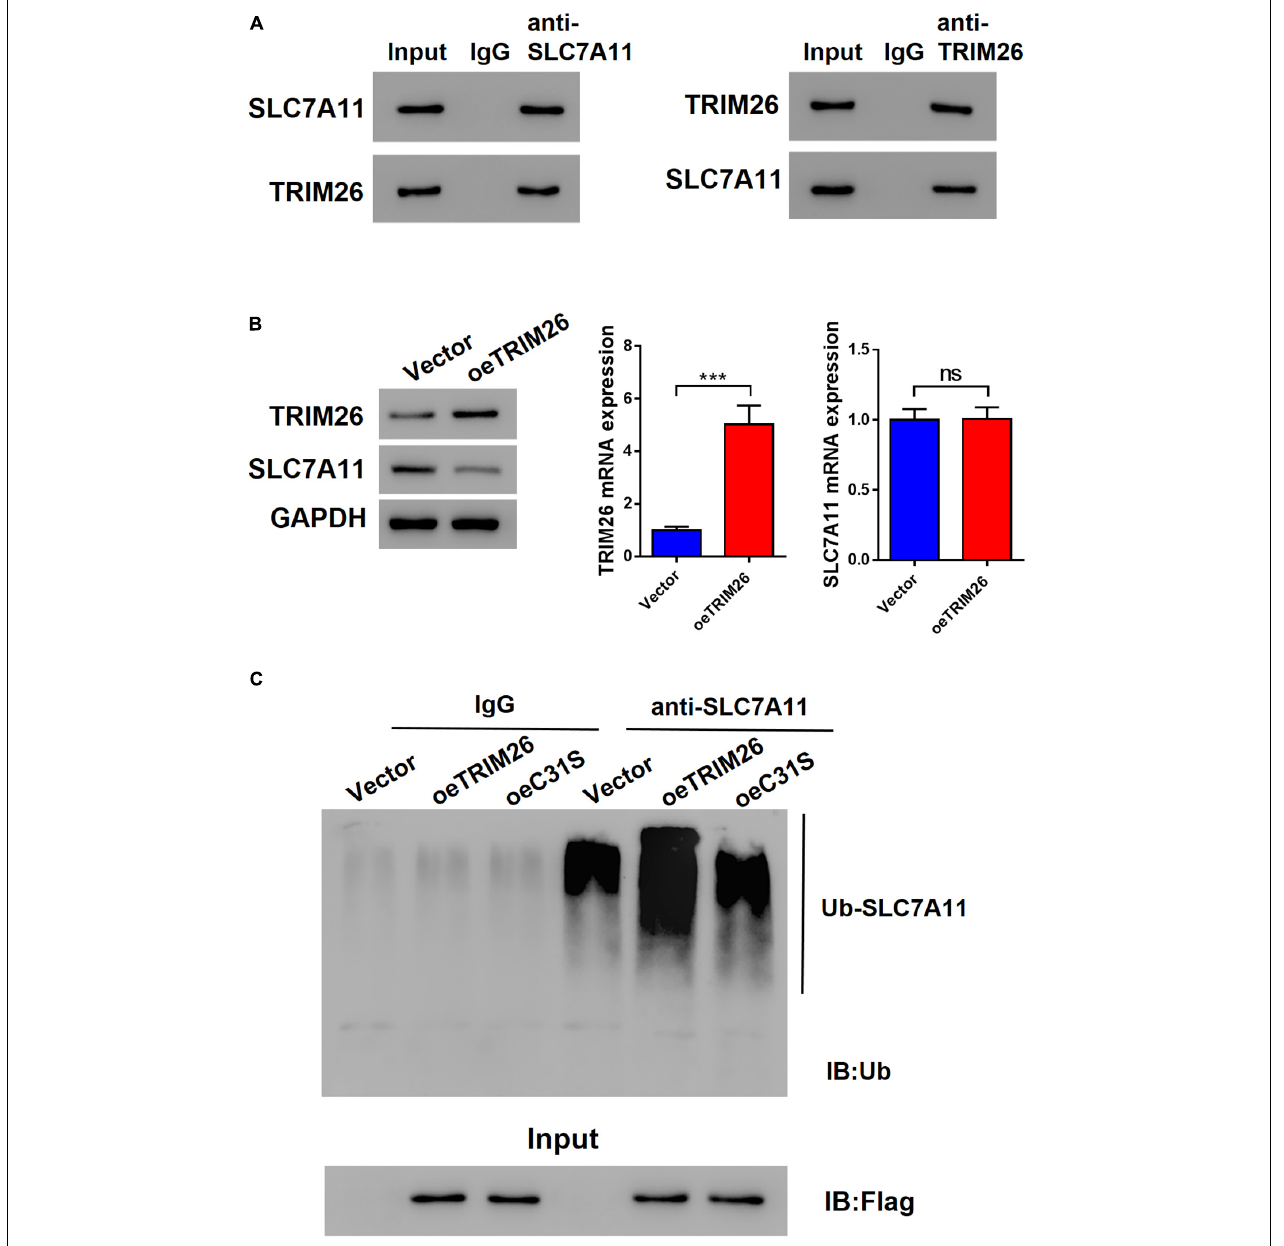
FIGURE 4 | Interactions between TRIM26 and SLC7A11. (A) Co-immunoprecipitation of TRIM26 and SLC7A11 in LX-2 cells. (B) Protein and mRNA expressions of TRIM26 and SLC7A11 in Vector- or oe TRIM26 plasmid-transfected LX-2 cells. (C) SLC7A11 ubiquitination in Vector-, oe TRIM26 plasmid, or oe C31S plasmid-transfected LX-2 cells. *** P < 0.001. ns: not significant.